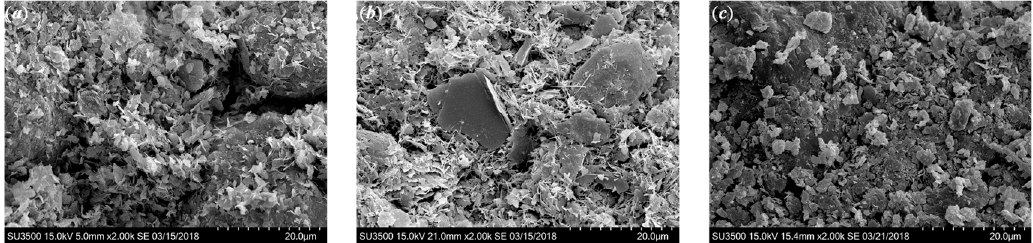
Figure 13. SEM images of cemented dredged clays with 1‰ SAP at different curing times: ( a ) 7 days, ( b ) 28 days, and ( c ) 90 days.